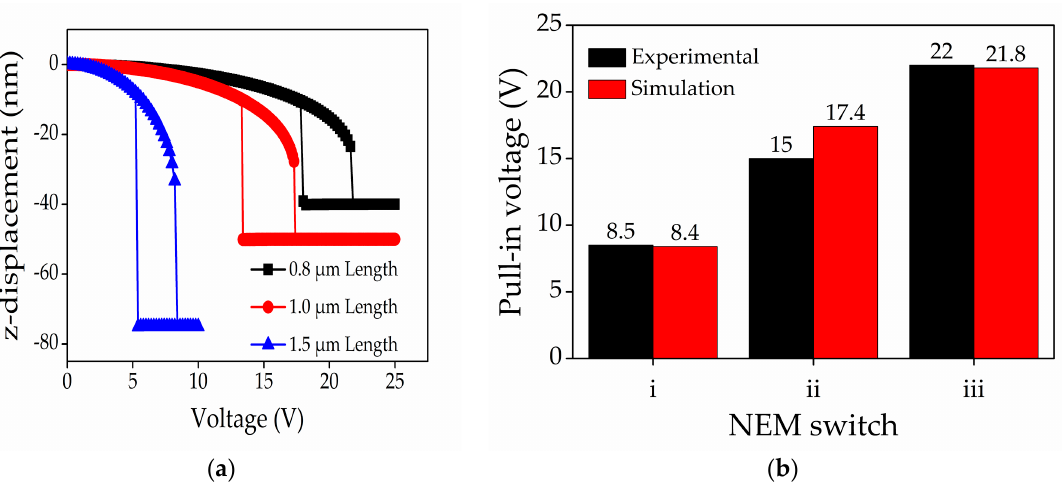
Figure 5. ( a ) Simulation data of actuation pull-in voltage characteristics for fixed-fixed ends graphene-based NEM switch; ( b ) comparison of pull-in voltage between experimental and simulation data for model validation process.